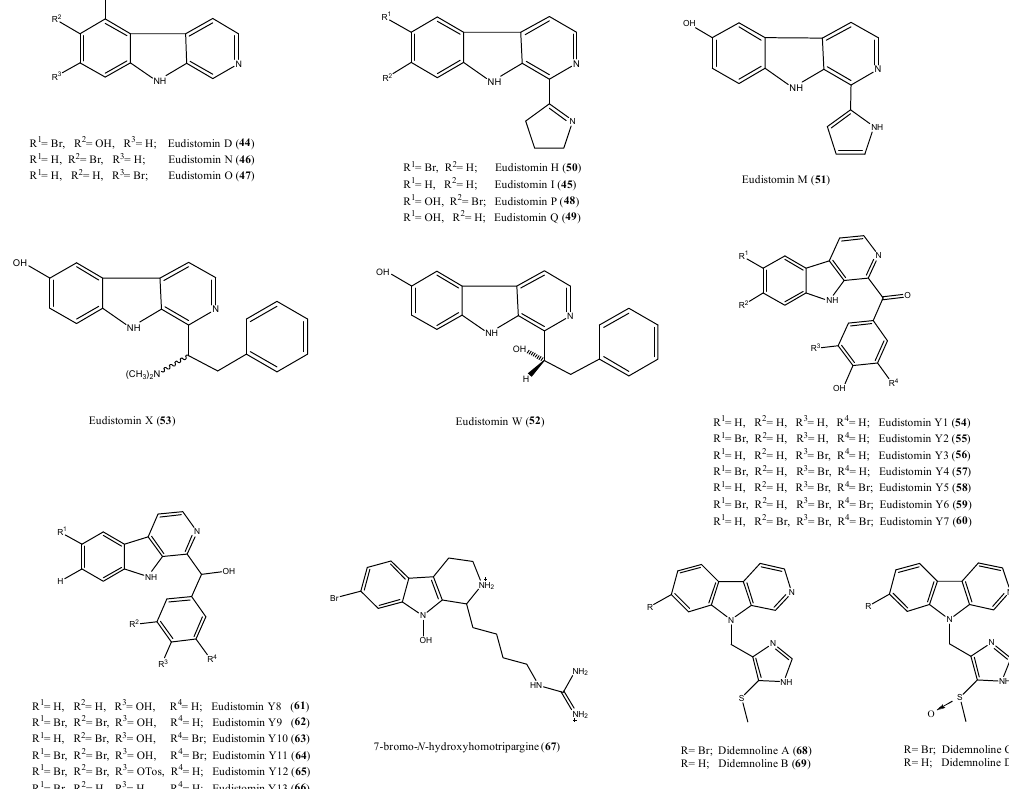
Figure 8. Structures of the β -carbolines alkaloids eudistomins ( 44 – 66 ), 7-Bromo- N - Figure8. Structuresofthe β -carbolinesalkaloidseudistomins( 44 – 66 ),7-Bromo- N -hydroxyhomotrypargine hydroxyhomotrypargine ( 67 ), and didemnolines A–D ( 68 – 71 ). ( 67 ), and didemnolines A–D ( 68 – 71